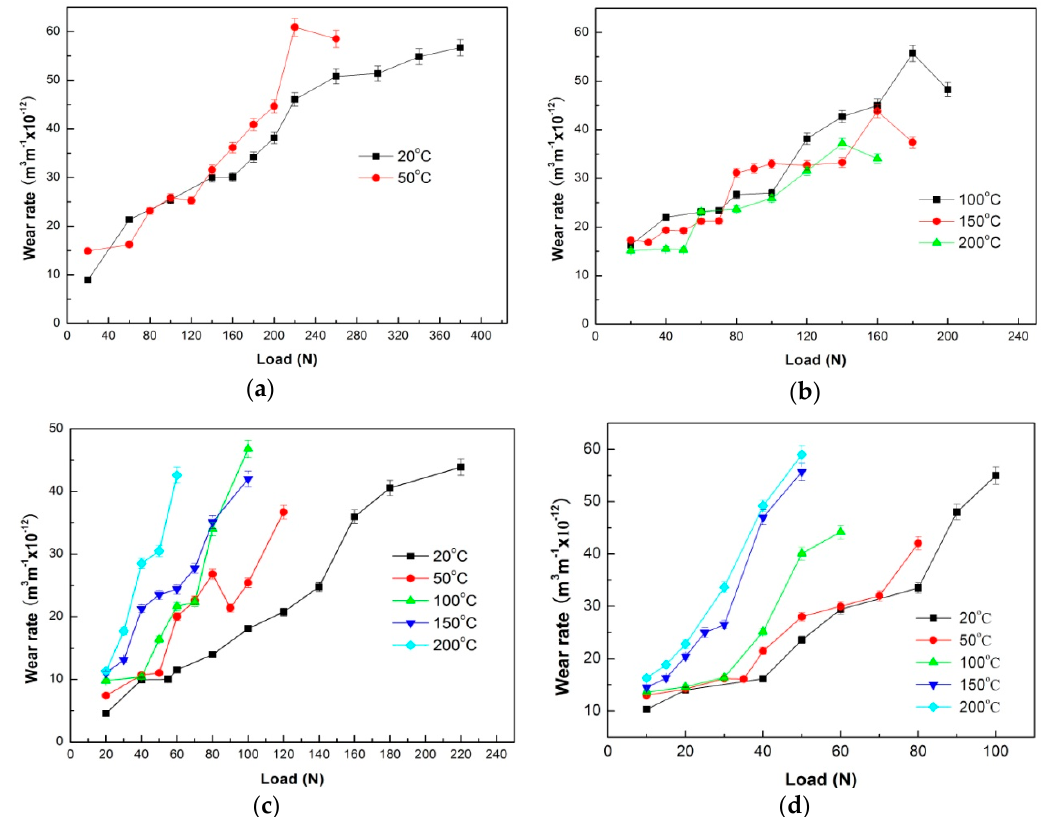
Figure 1. Variations of wear rates of Mg97Zn1Y2 alloy with applied load under different sliding conditions: ( a ) 20–50 °C, ( b ) 100–200 °C, 0.8 m/s, ( c ) 3.0 m/s, ( d ) 4.0 m/s.